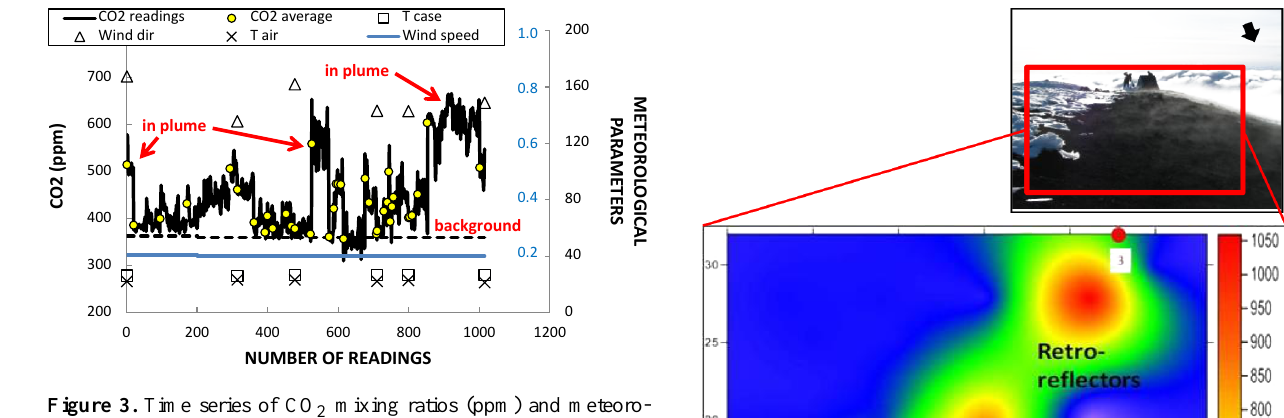
Figure 3. Time series of CO 2 mixing ratios (ppm) and meteoro- logical conditions for the Nea Kameni example ( ∼ 4h of observa- tions). The meteorological measurements were acquired from the INGV-type station temporarily installed on the summit crater (ex- cept wind speed, which was measured using a portable weather station). T case: temperature inside the station ( ◦ C); T air: out- side air temperature ( ◦ C); Wind dir: wind direction ( ◦ N); Wind Speed: average wind speed (0.2ms − 1 , blue line) during field oper- ation; dashed black line: CO 2 background average. CO 2 measure- ments at plume margins, oscillating close to the background values, are plotted. In-plume cross sections (CO 2 mixing ratios peaking at ∼ 600ppm) are shown. CO 2 average values (ppm) for each laser- mirror path are also given. The right vertical axis refers to the mete- orological parameters (blue units, range of 0–1, for the wind speed; black units, range of 0–200, for the air and case temperature, and Figure 4. Contour map of CO 2 mixing ratios (ppm), Hekla cam- wind direction). paign of 2 July 2013. GasFinder and retro-reflector positions are shown with letters and numbers, respectively. Blue triangle: INGV- PA/IMO station; red arrow: principal direction of plume